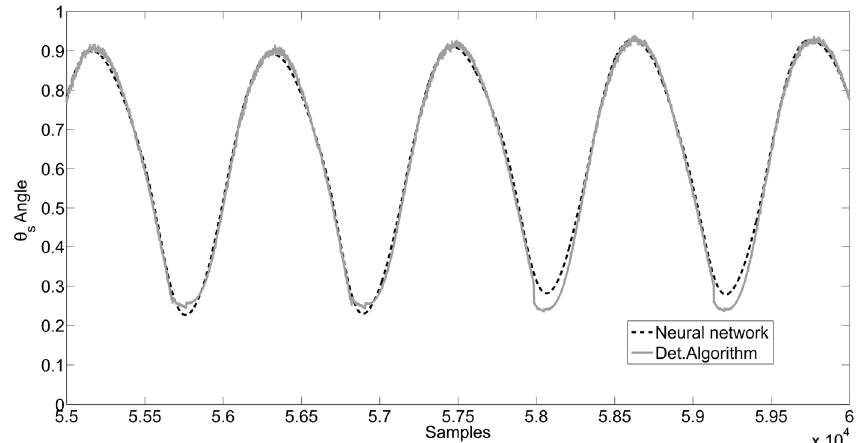
Figure 5. Angle θ S signals, obtained by the deterministic optimization algorithm (solid gray) and by the neural network (dashed black).